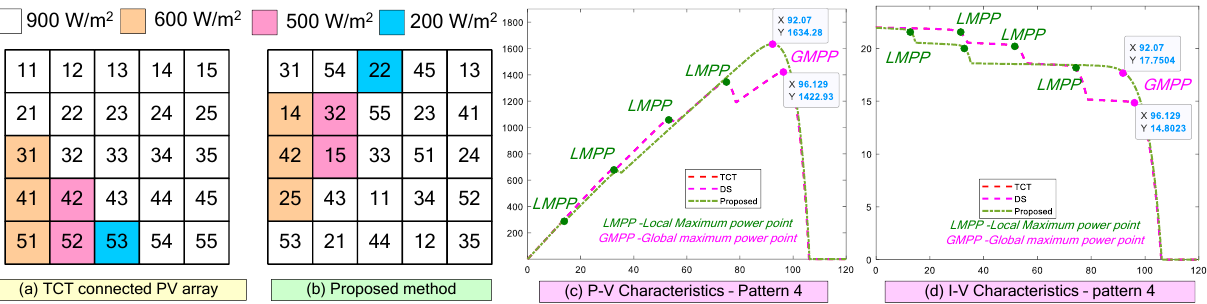
Figure 6. Shade pattern 3: ( a ) TCT arrangement, ( b ) Proposed arrangement, ( c ) P – V characteristics, ( d ) I – V characteristics.